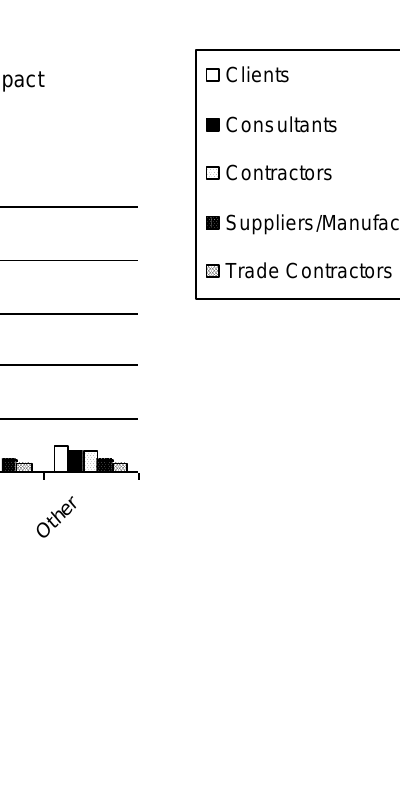
Figure 5 : Profitability effect of most successful